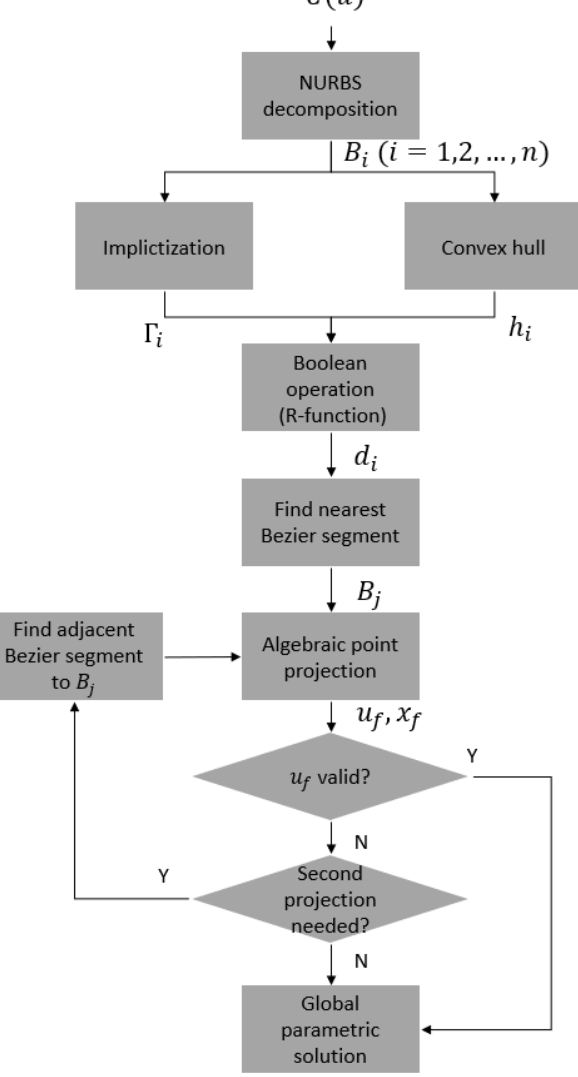
Figure 15. Flowchart for execution of algebraic point